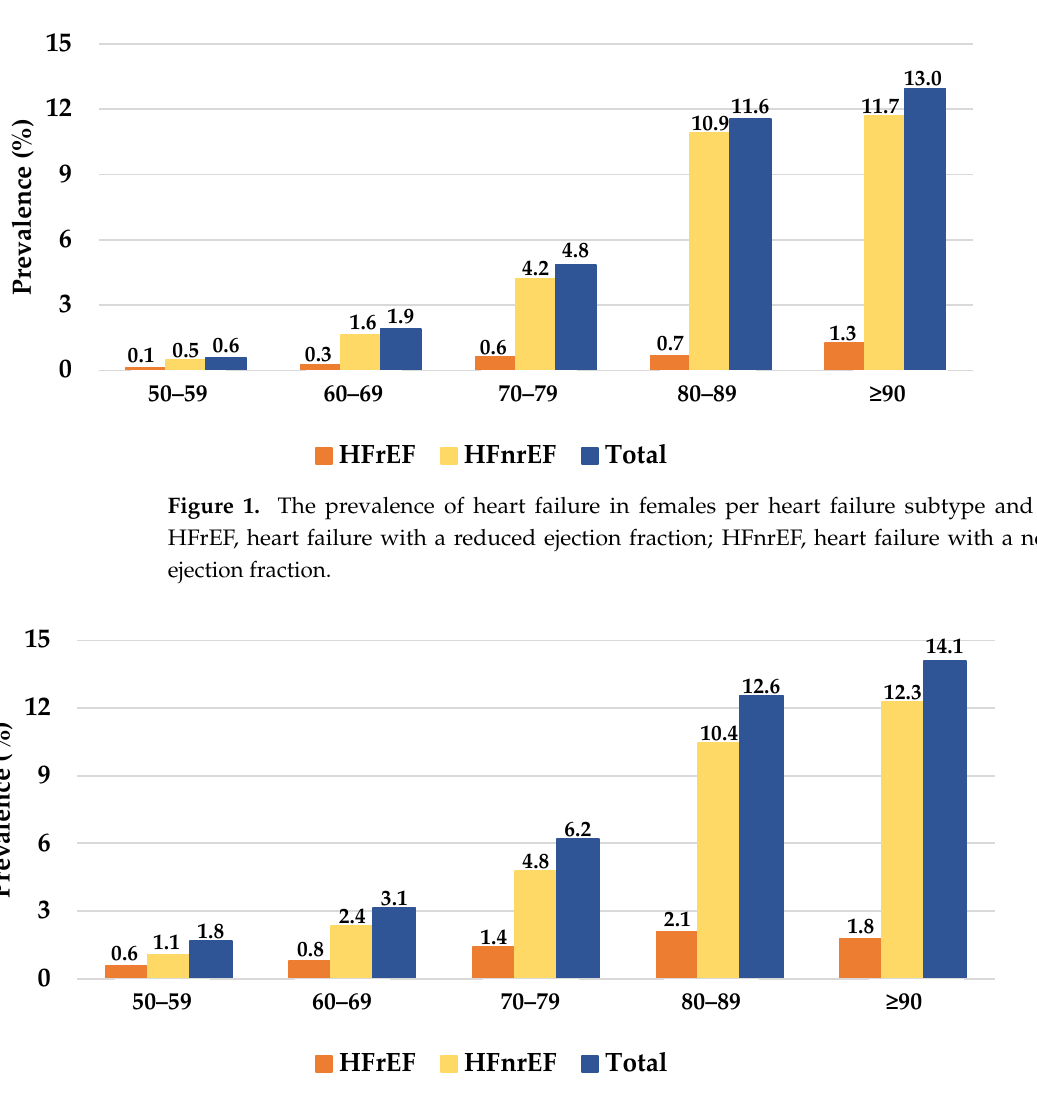
Figure 2. The prevalence of heart failure in males per heart failure subtype and age group. HFrEF, heart failure with a reduced ejection fraction; HFnrEF, heart failure with a non-reduced ejection fraction.